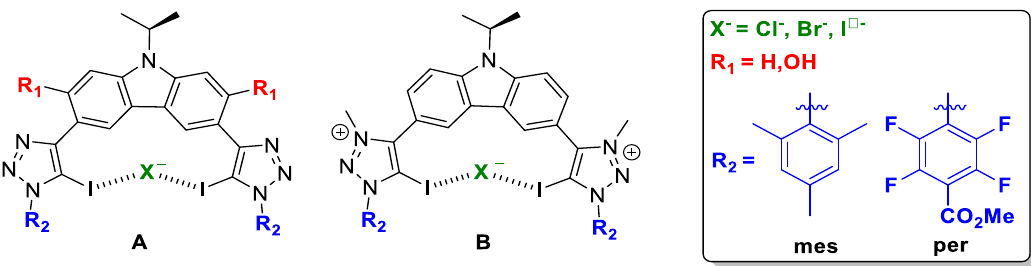
Figure 2. Schematic representation of the compound subject to study: ( A ) neutral XB donor motif and ( B ) cationic XB donor motif.